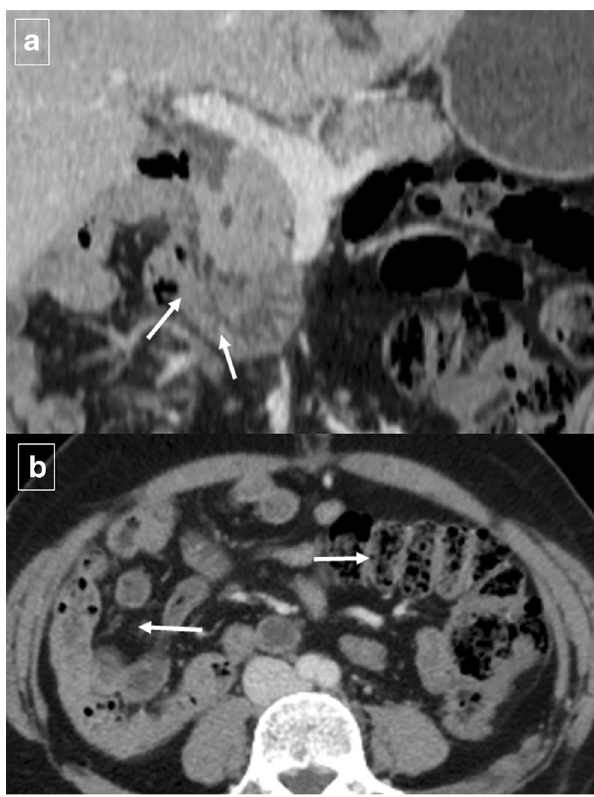
Fig. 6 Gastrointestinal nonrotation in a 46-year-old woman. a Reformatted coronal contrast-enhanced CT image shows that the third portion of the duodenum (arrows) does not cross the midline of the abdomen. b The small bowel is located in the right side of the abdomen and the colon in the left side (arrows) on axial CT image